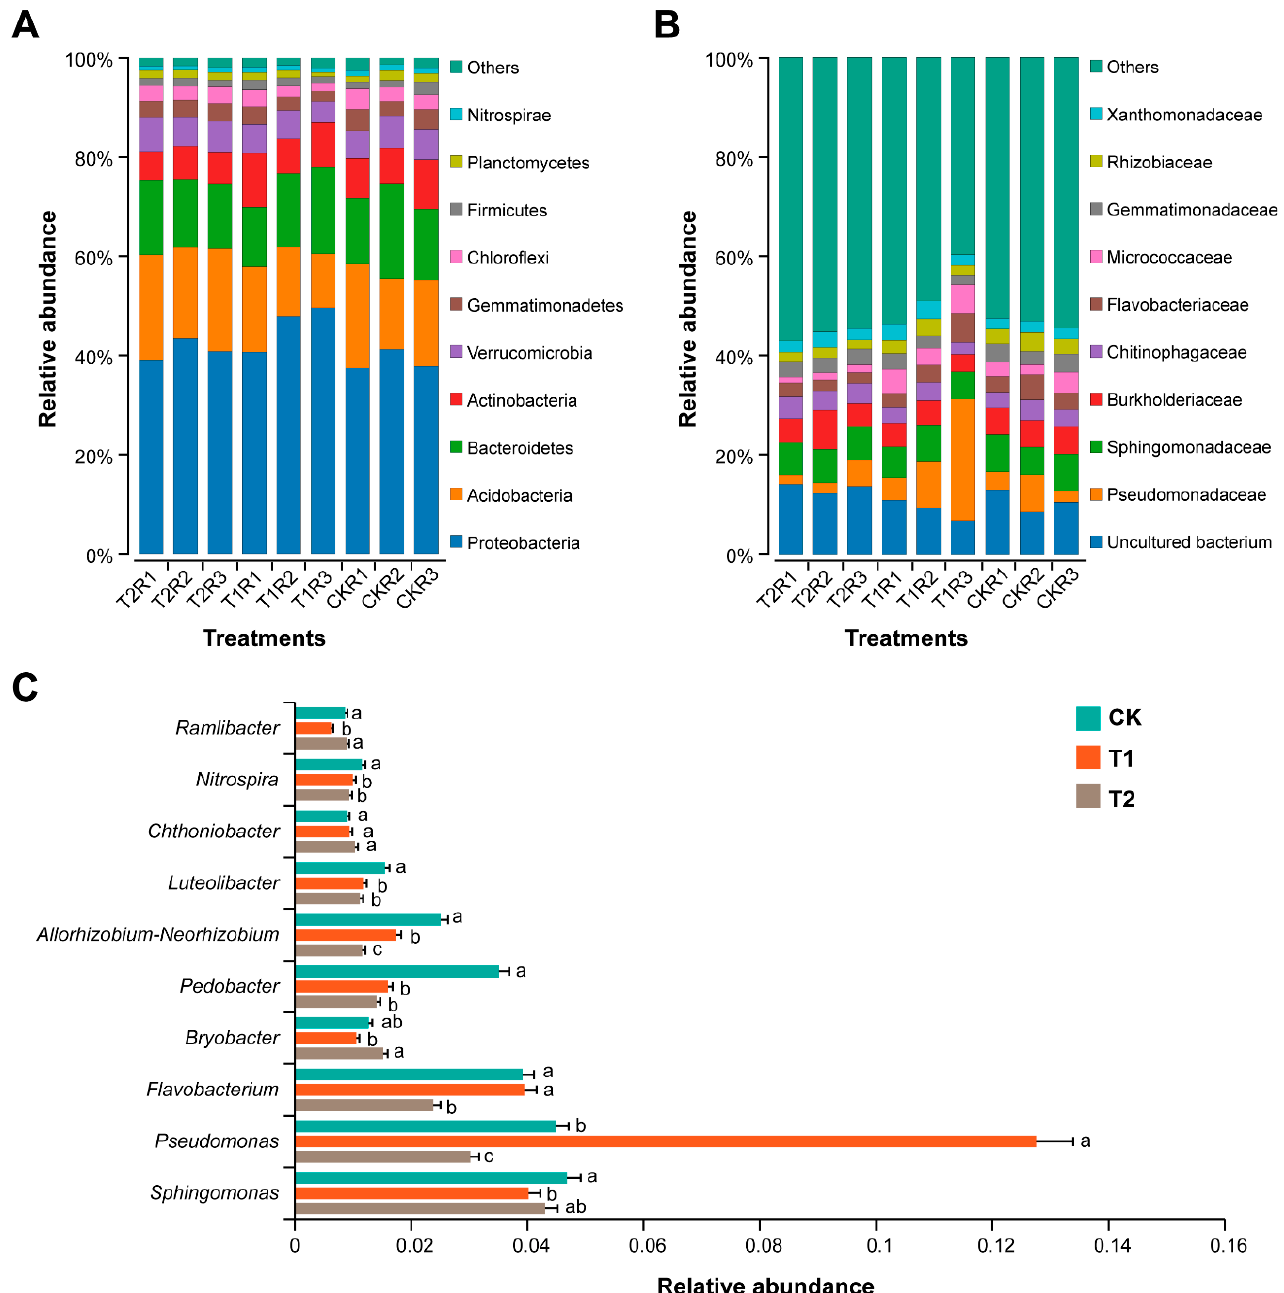
Figure 5. Distribution of most dominant bacterial communities at phylum, family, and genus levels under different treatments ( ± SEM; n = 3/treatment). Bar plots for the 10 most abundant dominant bacterial phyla ( A ), families ( B ), and genera ( C ). Different lowercase letters on the error bars represent the significant differences among treatments, according to a least significant difference test (LSD; p < 0.05). Monocropping of Chinese cabbage (CK), Chinese cabbage seedlings were transplanted immediately after harvesting the marigold crop (T1), and Chinese cabbage seedlings were transplanted with an empty period of 15 days after harvesting the marigold crop